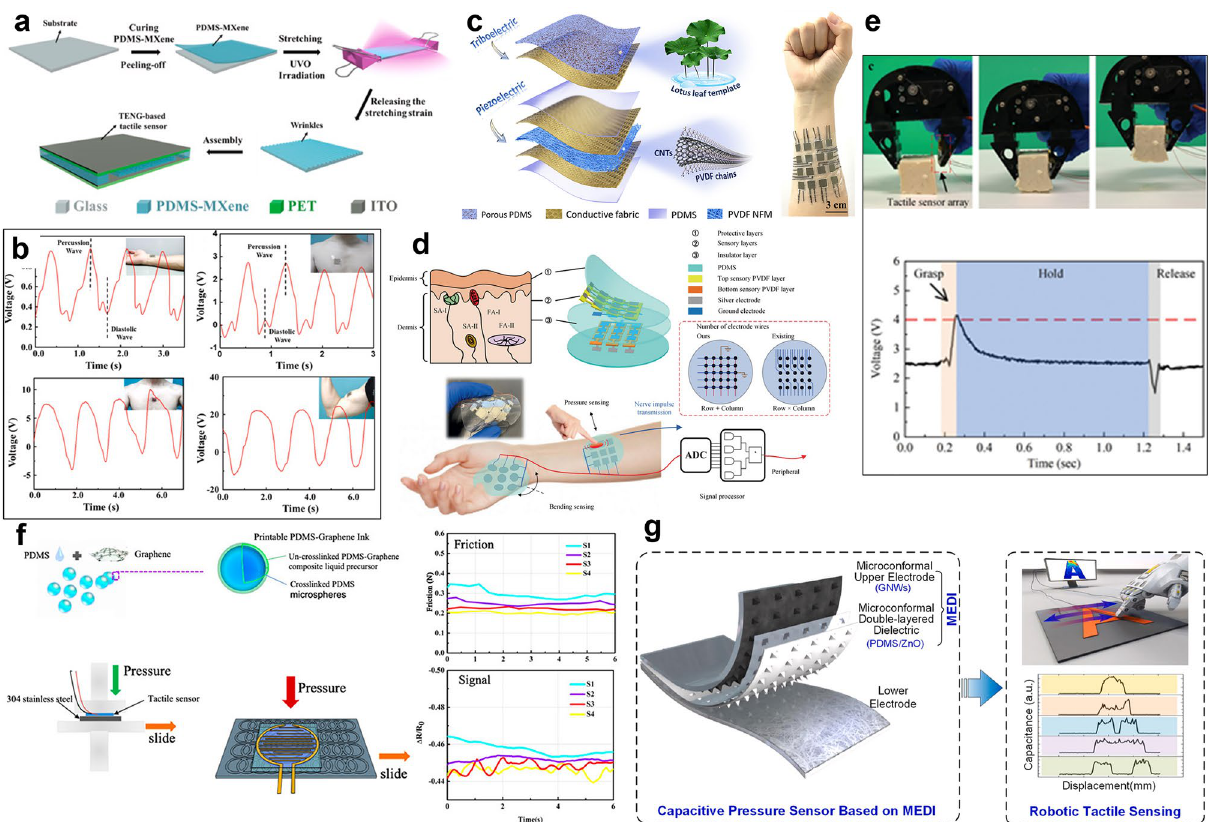
Fig. 12 Soft tactile sensation sensor. a Schematic diagram of the triboelectric tactile sensor fabrication process. b Voltage–time waveform of the sensor under pulse, heartbeat, breath, and flexion and extension of biceps. Reproduced with permission [262]. Copyright (2021), Elsevier. c Schematic diagram of the battery-free e-skin structure. Reproduced with permission [263]. Copyright (2021), Elsevier. d Schematic diagram of the skin-inspired piezoelectric tactile sensor array. A large number of sensor pixels can be fabricated with a small quantity of wires. e Sensor array placed on the robot hand and the tofu block grasped by real-time feedback. Reproduced with permission [264]. Copyright (2021), Wiley– VCH. f Response of the graphene-PDMS microsphere structure tactile sensor to items with different roughness. Reproduced with permission [266]. Copyright (2021), American Chemical Society. g Schematic diagram of soft piezocapacitive sensor structure and slipping imaging of sur- faces with different roughness. Reproduced with permission [267]. Copyright (2021),